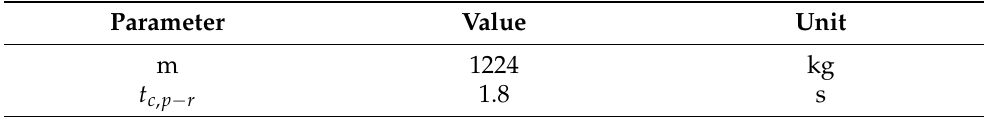
Table 3. Simulation parameters (vehicle-related) used in this